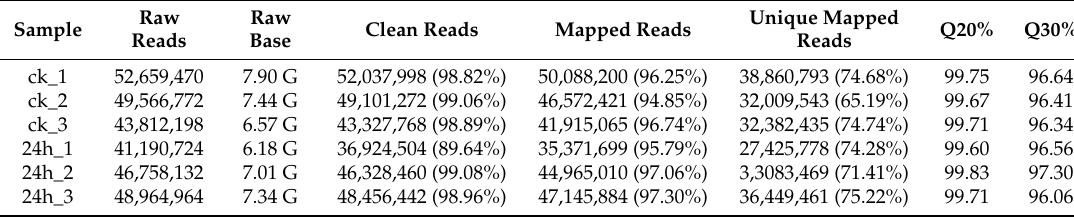
Table 1. Overview of the watermelon leaf RNA sequencing (RNA-Seq) data.